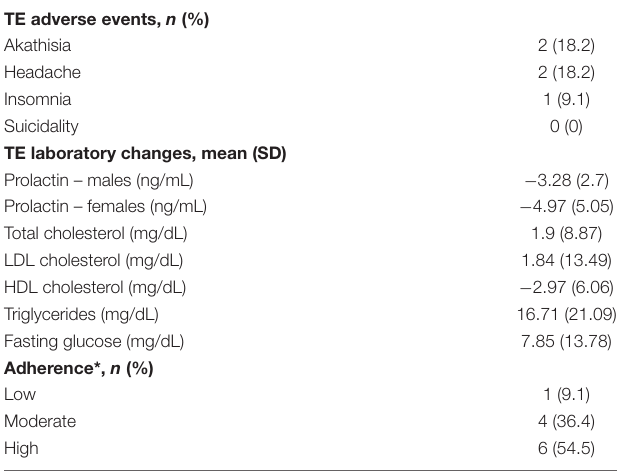
TABLE 2 | Summary of the safety outcome